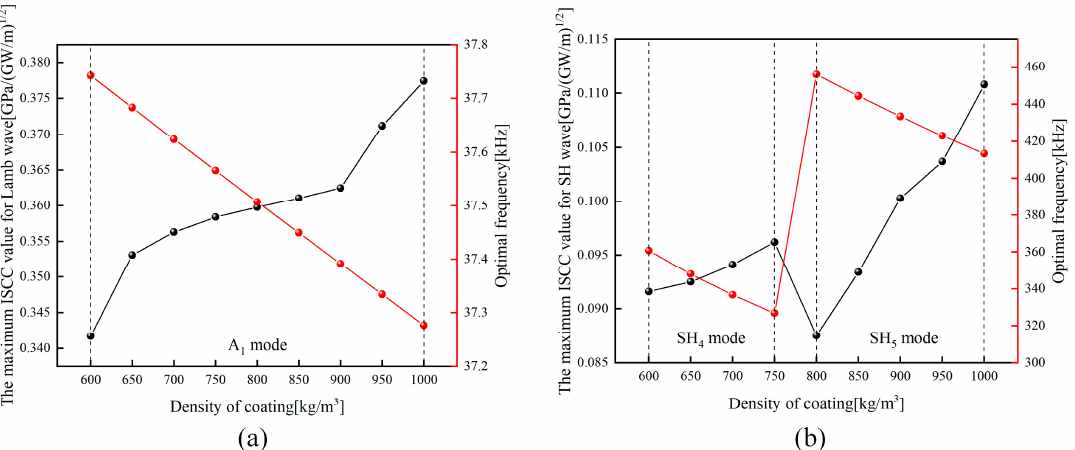
Figure 8. The effects of coating density on the maximum ISCC value and the optimal frequency: ( a ) Lamb waves; ( b ) SH waves.